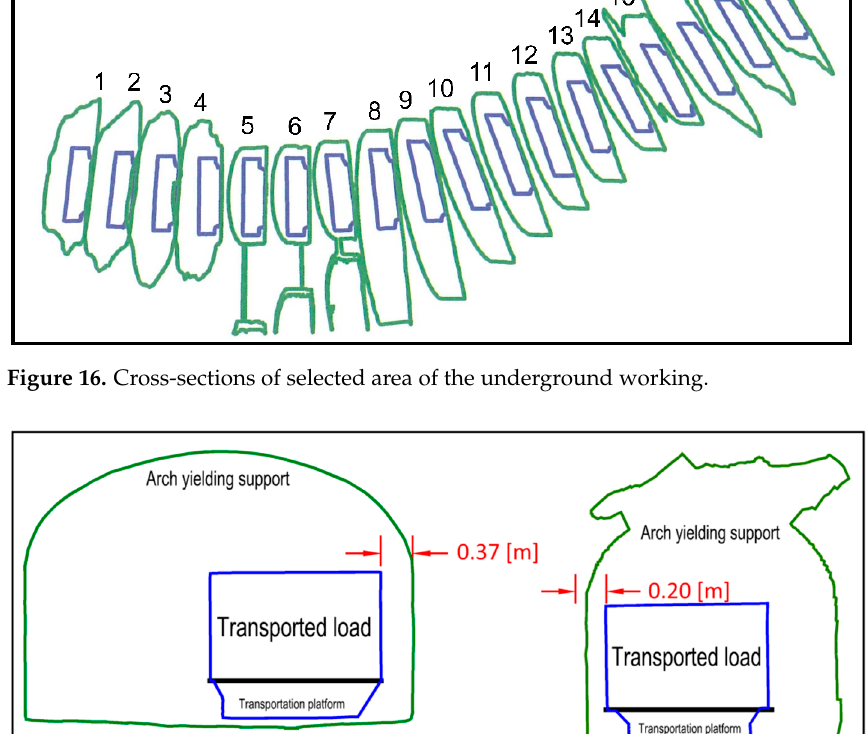
Figure 17. Selected cross-sections (9 and 15) of the underground